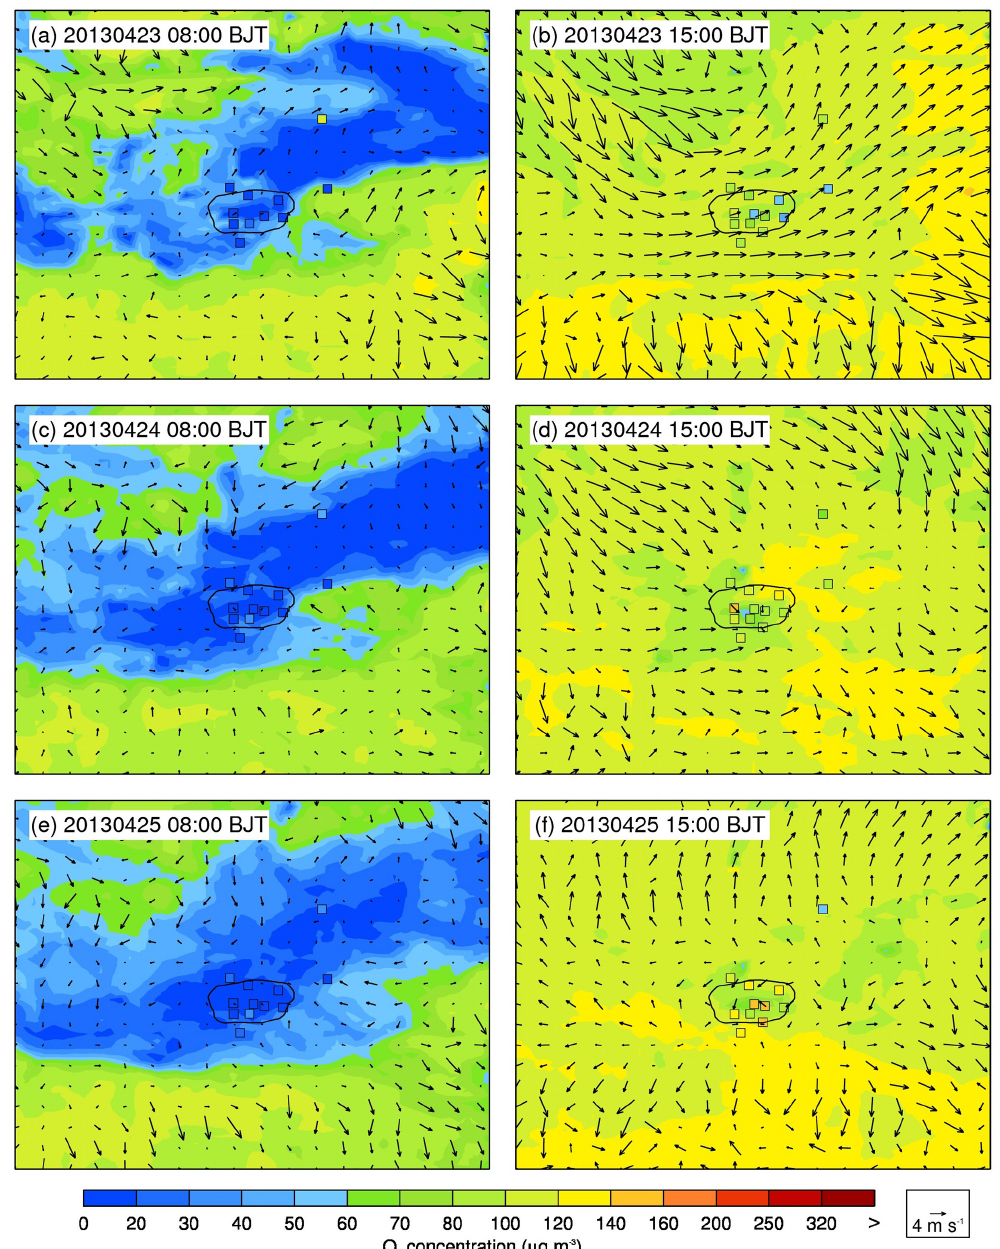
Figure 5. Spatial patterns of calculated (contours) and observed (squares) O 3 concentrations at 08:00 and 15:00BJT from 23 to 25 April 2013 along with wind fields (back